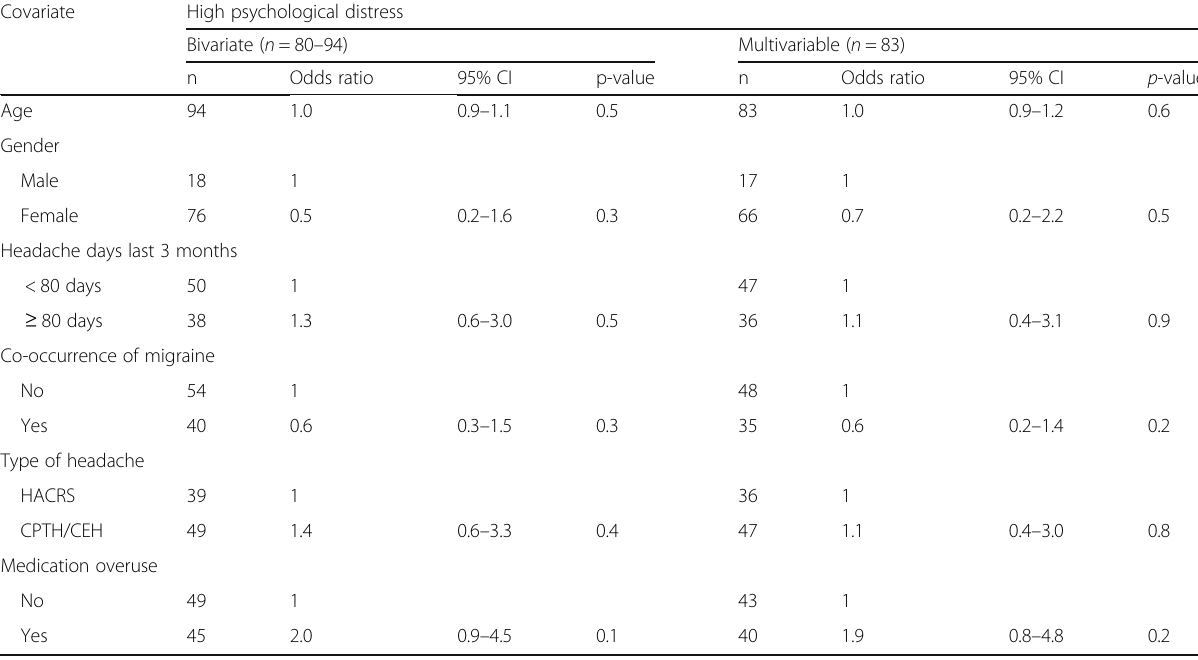
Table 2 Odds for having high psychological distress defined as mean HSCL-25 score ≥ 1.67 for men and ≥ 1.75 for women. Logistic regression